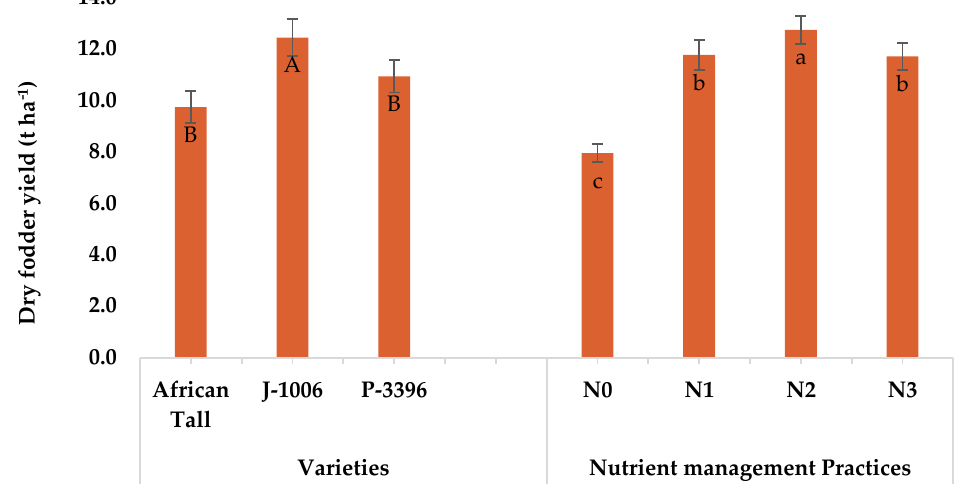
Figure 1. Dry fodder yield of maize varieties sown under different nutrient management practices (mean of two years). Note: Vertical bars labelled with different upper and lower-case letters shows significant variations among varieties and nutrient management practices, respectively using LSD ( p = 0.05); Capped lines indicate the standard error of mean.3.2. Source-Wise and Operation-Wise Energy Inputs and Their Percentage Share